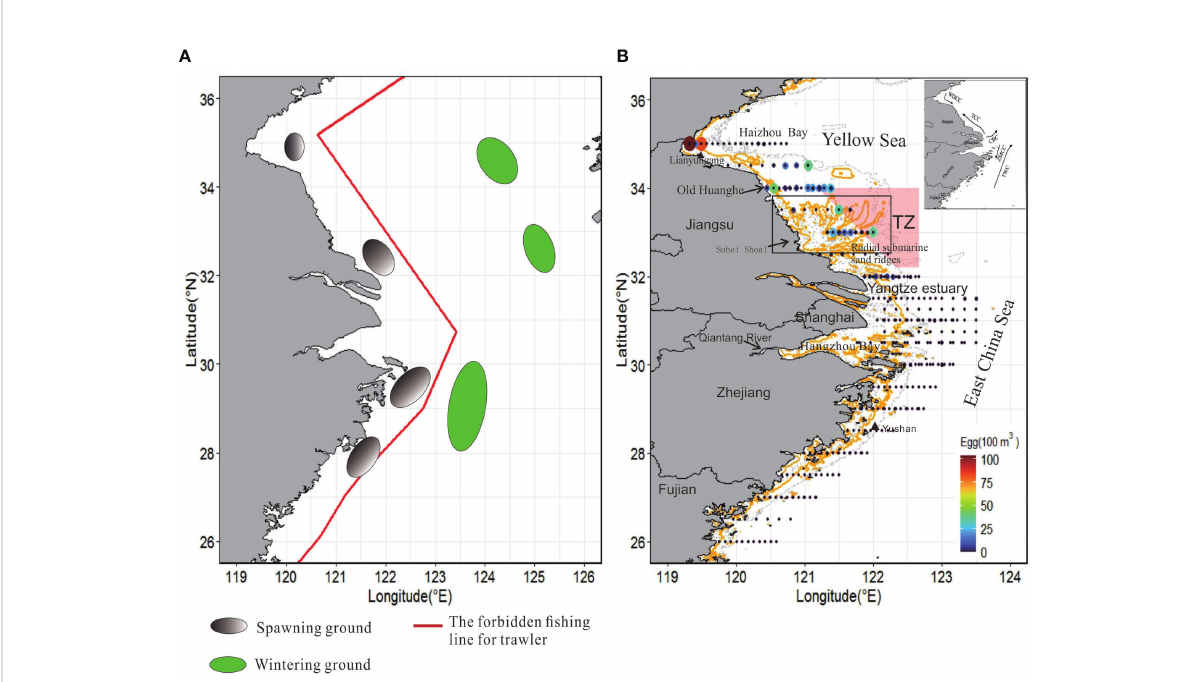
FIGURE 1 (A) The previous reported spawning grounds and overwintering grounds distribution of small yellow croaker in the coastal waters (Ren et al., 2020). (B) Geographical range and spatial distribution of fi sh egg abundance. The administrative regions within the survey range are displayed, including Jiangsu, Shanghai, Zhejiang, and Fujian. The survey results for stations and abundance in 2005 and 2008 reveal that the solid gold line is a 10 m isobath, the dashed gray line is a 5 m isobath, and the double dashed line is a 20 m isobath. The 10 m isobath along the Jiangsu coast re fl ects the existence of radial sand ridges. TZ represents the conservation zone for the small yellow croaker. The black triangle represents tide gauge stations. The coastal current system of China, wind-derived coastal current (WDCC), is shown on the upper right; TCC, tidal-induced coastal current; CBC, Changjiang bank current; ZMCC, Zhe-Min Coastal Current; TWC, Taiwan Warm